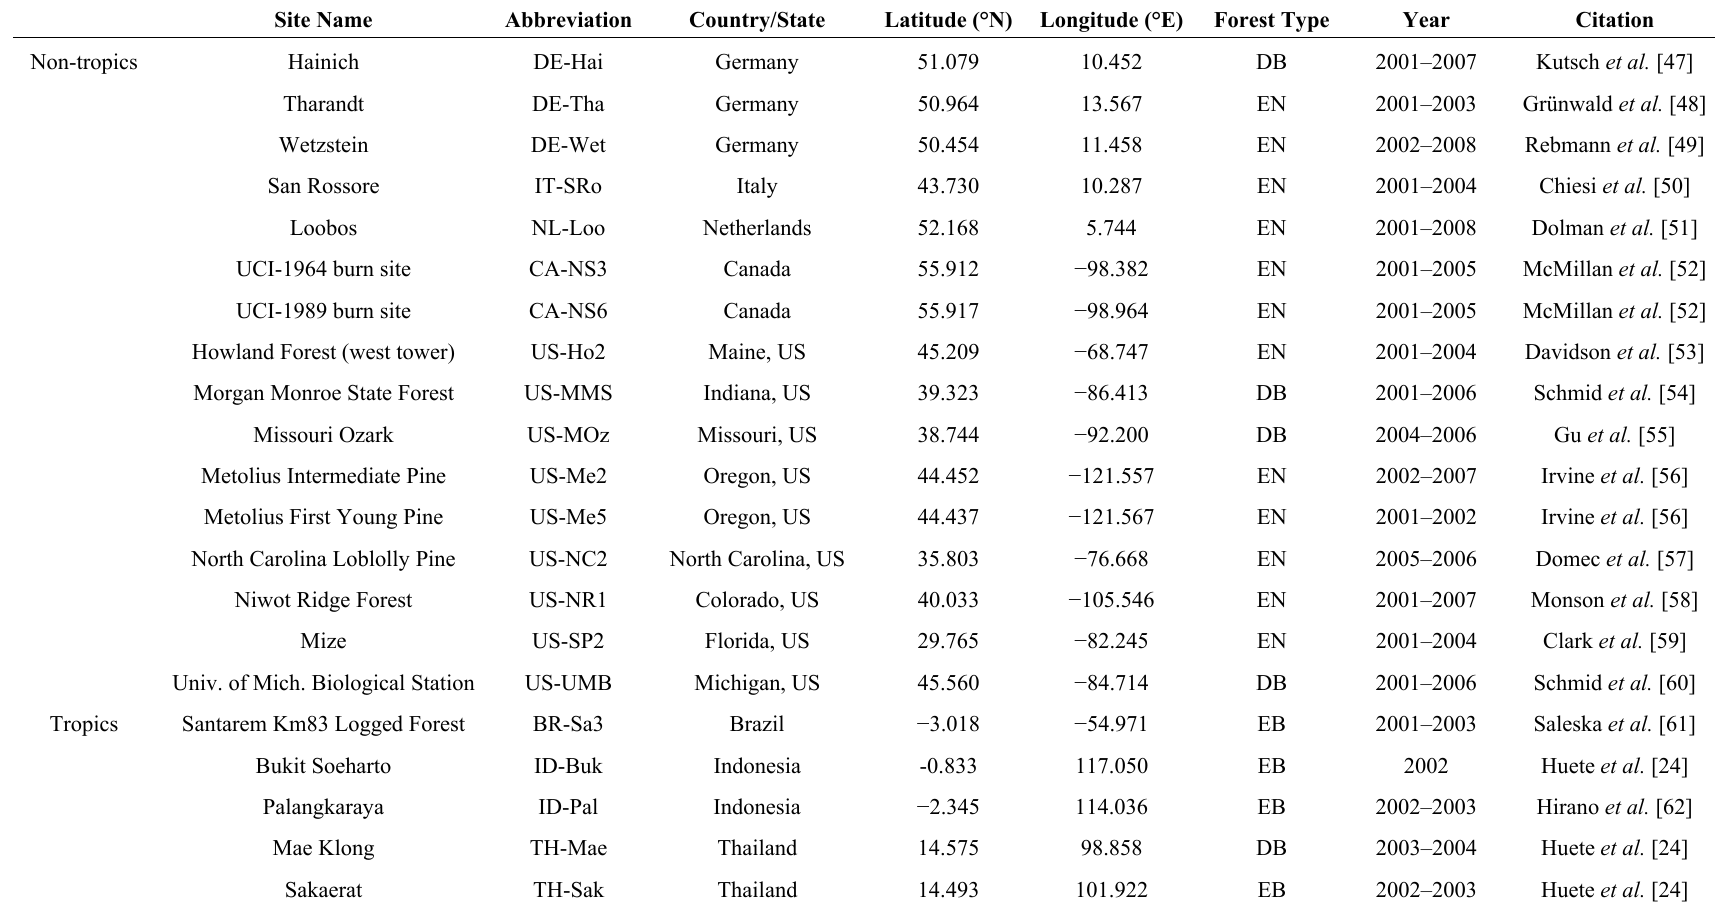
Table 2. Site description of flux towers used in this study. Forest types are: deciduous broad leaf forest (DB), evergreen needleleaf forest (EN), and evergreen broad leaf forest (EB). Note that the years given in the table refer to the available data before applying the criteria described in Sections 2.1 and 2.2, and thus the actual number of years used in the analysis may be